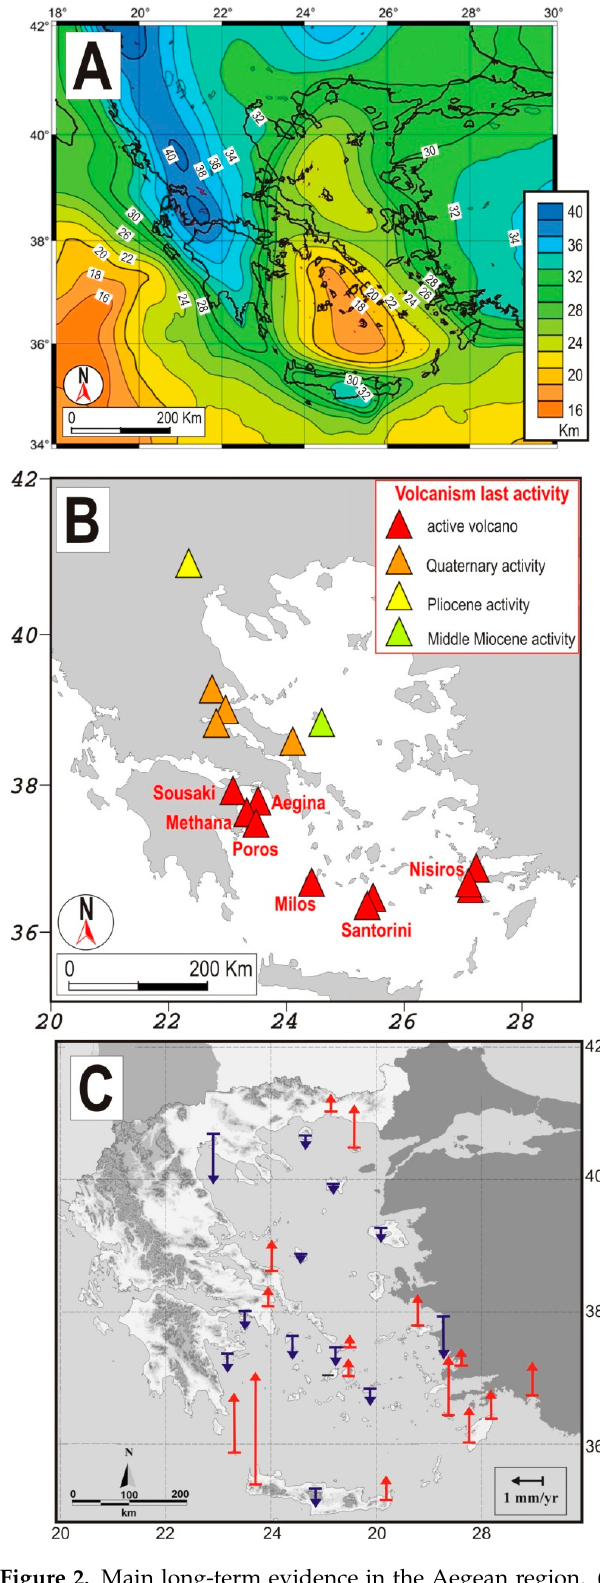
Figure 2. Main long-term evidence in the Aegean region. ( A ) Map of the Moho depth modified after [20,21]. ( B ) Distribution of volcanic activity modified after [22]. ( C ) Vertical displacement rates in Aegean coastal zones during the Holocene assessed by geoarchaeological data (modified after [23]).